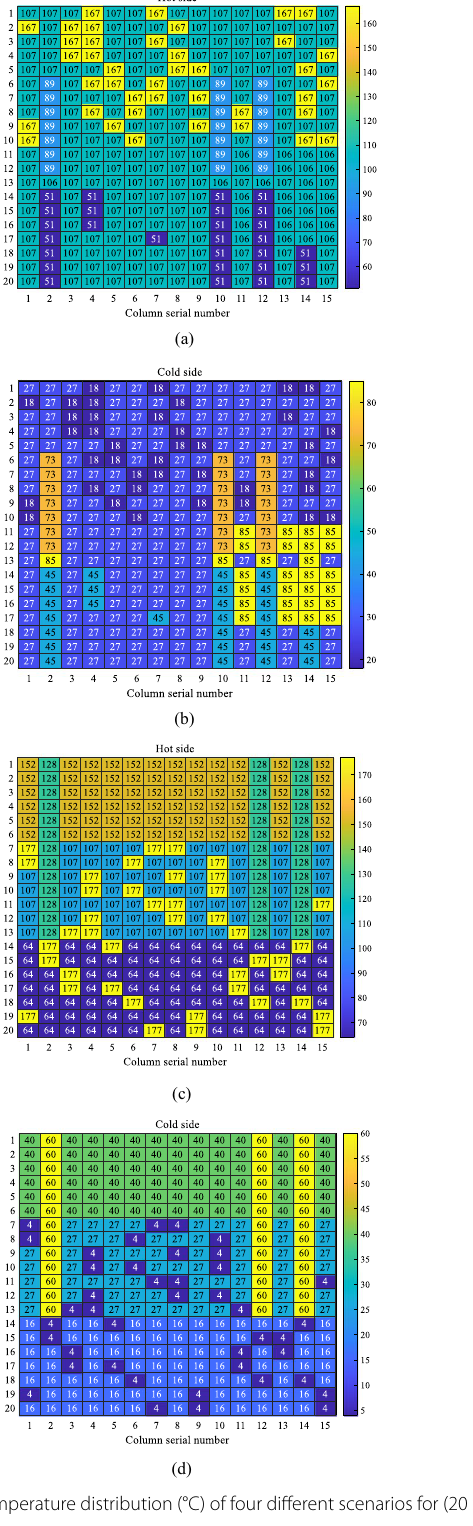
Fig. 11 Temperature distribution (°C) of four different scenarios for (20